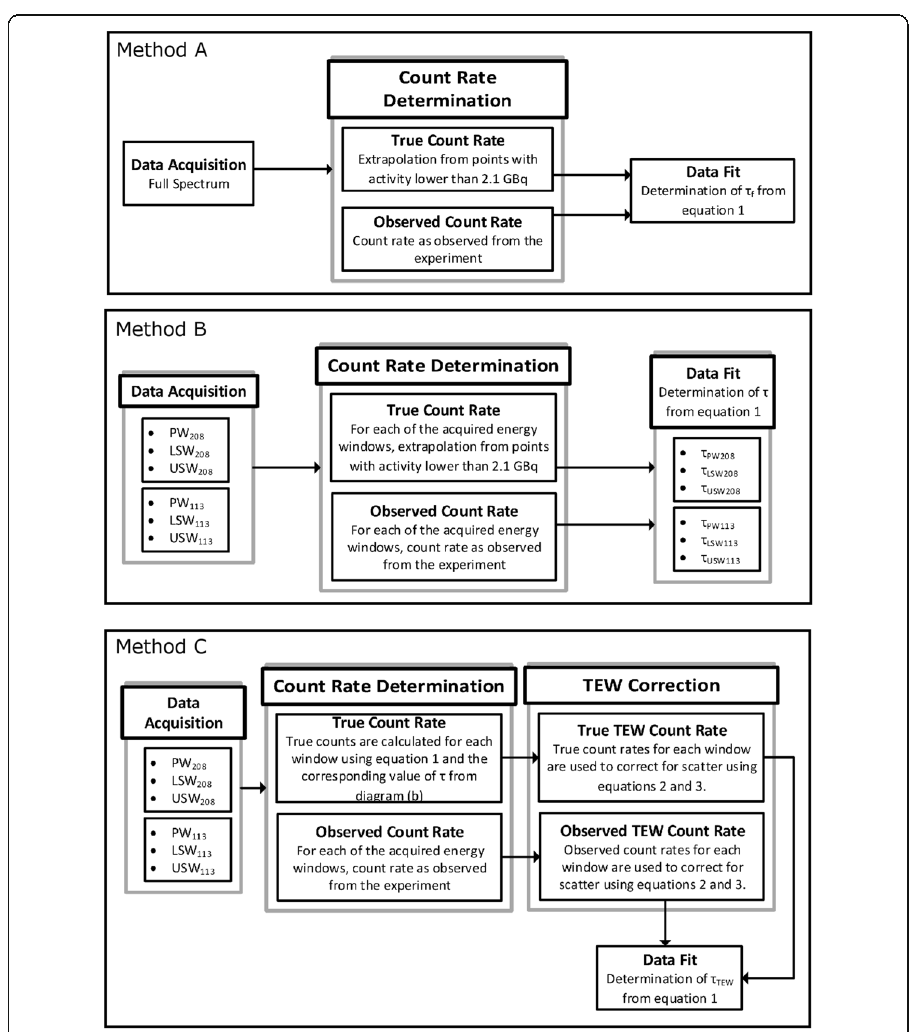
Fig. 2 Flow charts of the three methods used to calculate the camera